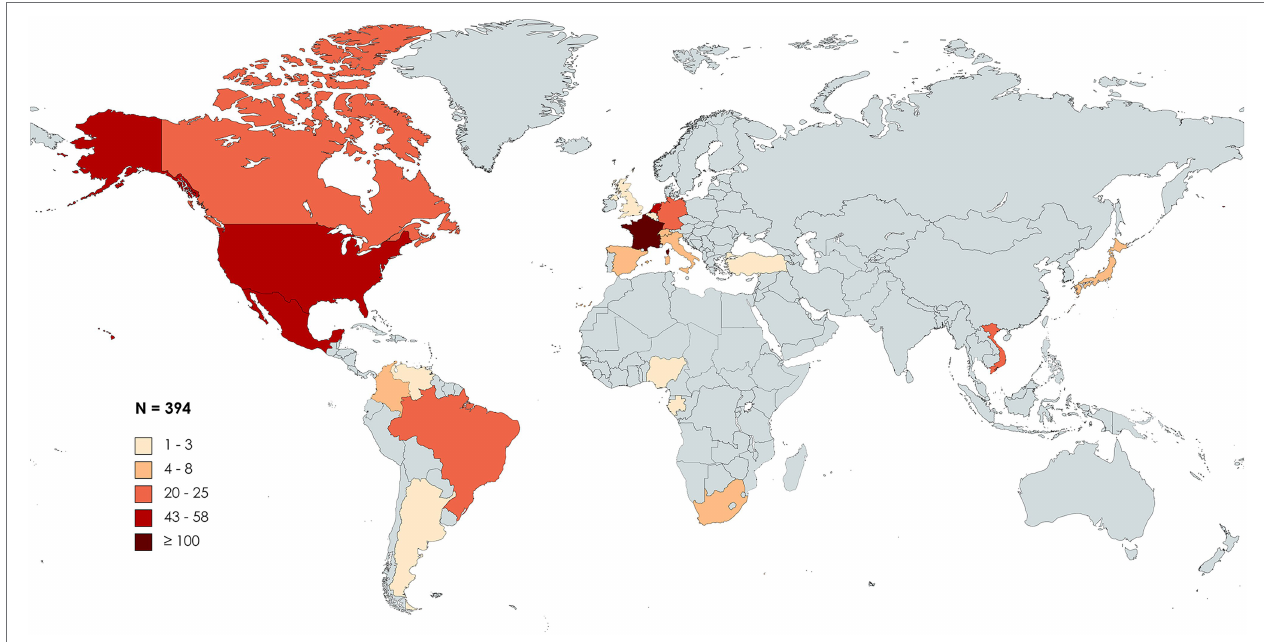
FIGURE 1 | Geographic distribution of genotype G (HBV/G)-infected patients. Global map distribution based on absolute number of HBV/G-infected patients in each country extracted from 55 articles analyzed in this study. The map was created with